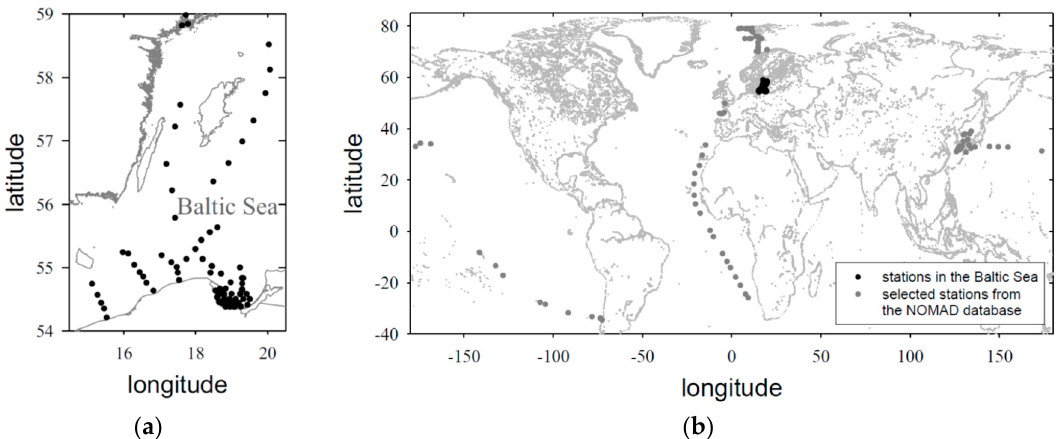
Figure 1. Sampling station locations: ( a ) stations in the southern and central Baltic Sea (authors’ own data); ( b ) stations in different regions of the global oceans (data from the NASA bio-Optical Marine Algorithm Dataset (NOMAD)).